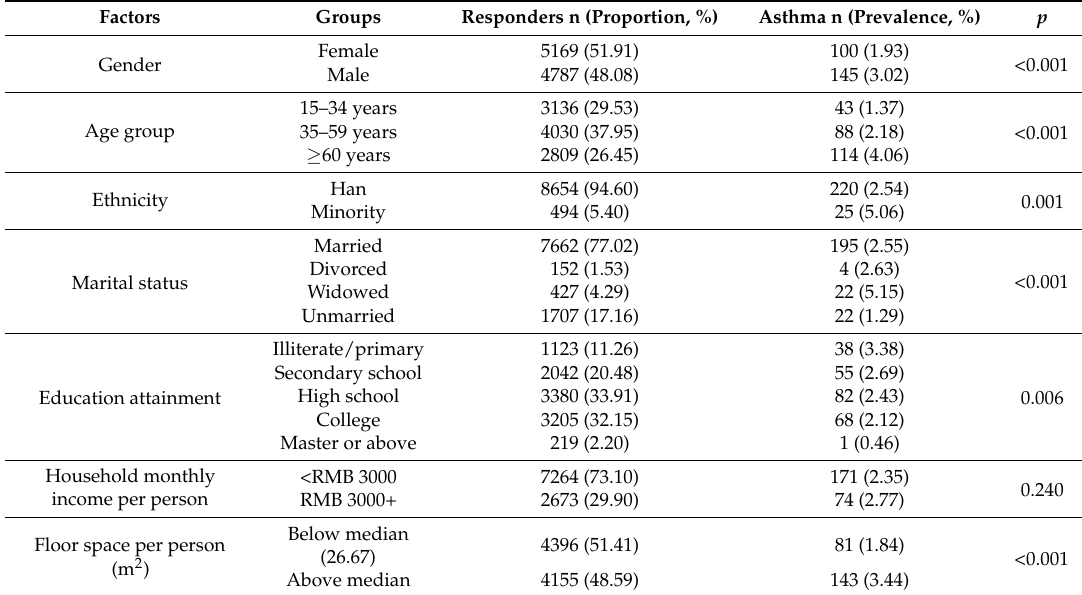
Table 2. Comparisons of the prevalence of lifetime asthma among different socio-demographic